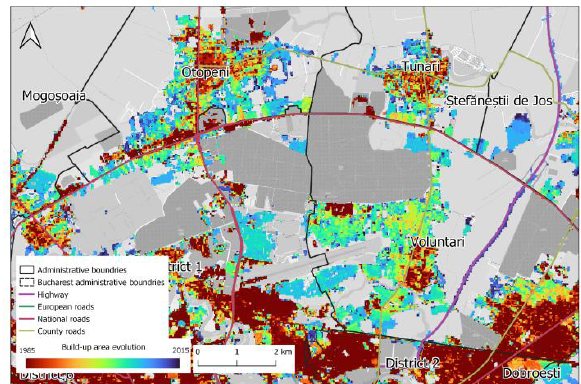
Figure 11 . Urban expansion of Bucharest between 1985 and 2015 - North (data source: WSF Evolution, DLR, CC-BY